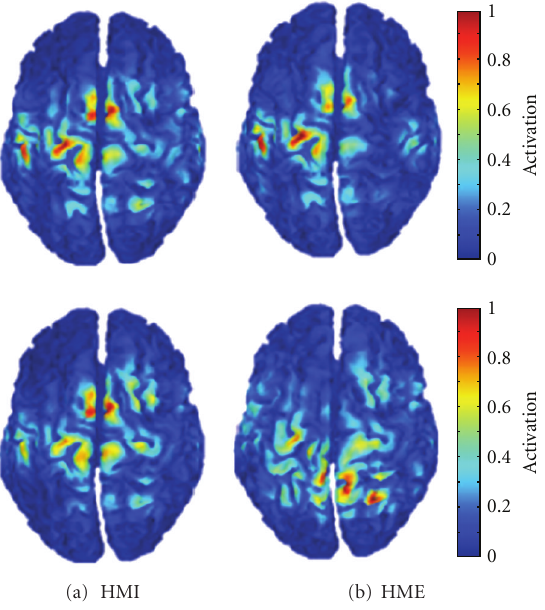
Figure 2: Cortical source activation maps for one subject during (a) Hand Motor Imagery (HMI) and (b) Hand Motor Execution (HME). Each row represents a di ff erent poststimulus instance, and the variance in activation patterns can be observed.